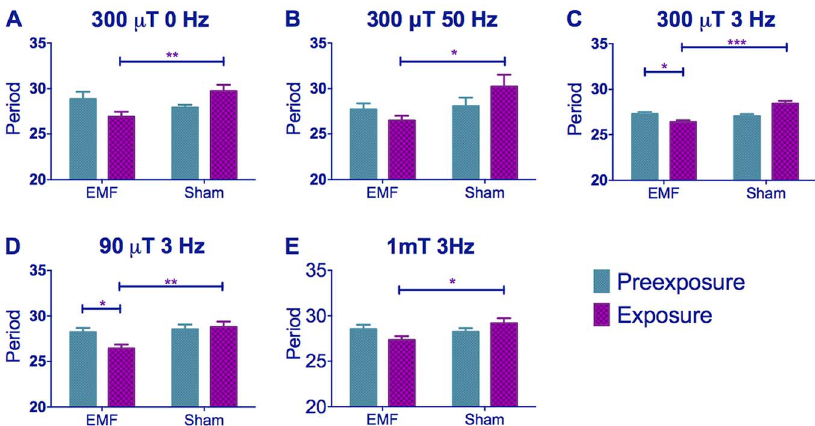
Figure 1. EMF exposure shortens free-running circadian periods in dim blue light. Mean circadian periods (h) + / 2 sem are shown for the EMF and sham-exposed groups. Note how periods are considerably longer than 24 h. (A–C) period changes in CS flies under static, 50 and 3 Hz field respectively at 300 m T (C–E) period changes in CS flies under 300, 90 and 1000 m T (1 mT) field respectively at 3 Hz. EMF-exposed flies show significant period shortening. For period and N see Table S1. ( post-hoc *p , 0.05, **p , 0.01, ***p ,